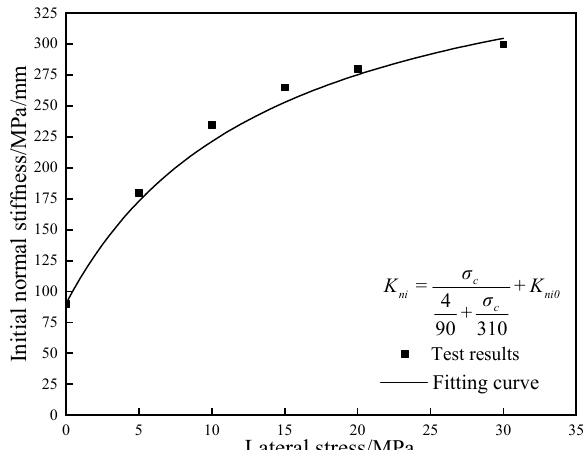
Figure 12. Comparison of the test and fitting results of the relationship between initial normal stiffness and lateral stress.